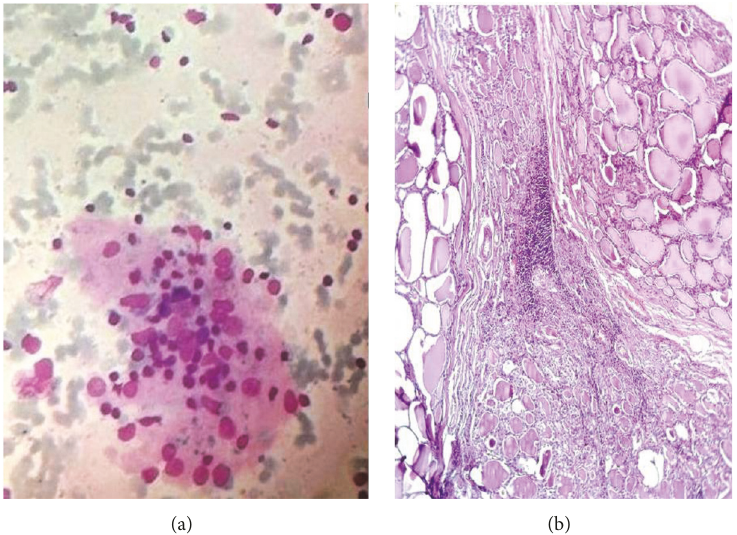
Figure 2: Hashimoto’s thyroiditis with colloid goiter: smears showing thin background colloid and follicular cell cluster infiltrated by lymphocytes (Leishman’s stain × 400); (b) Hashimoto’s thyroiditis with colloid goiter (Haematoxylin & Eosin ×